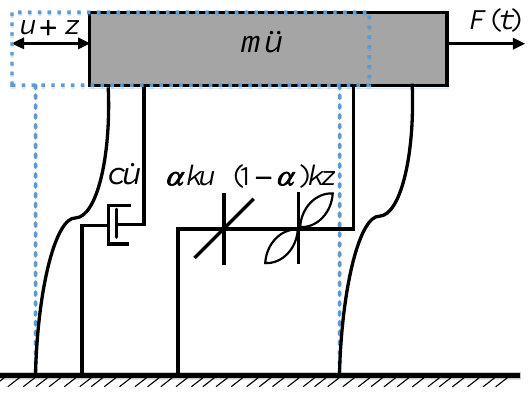
Figure 1. BWBN hysteretic model of SDOF System [62].